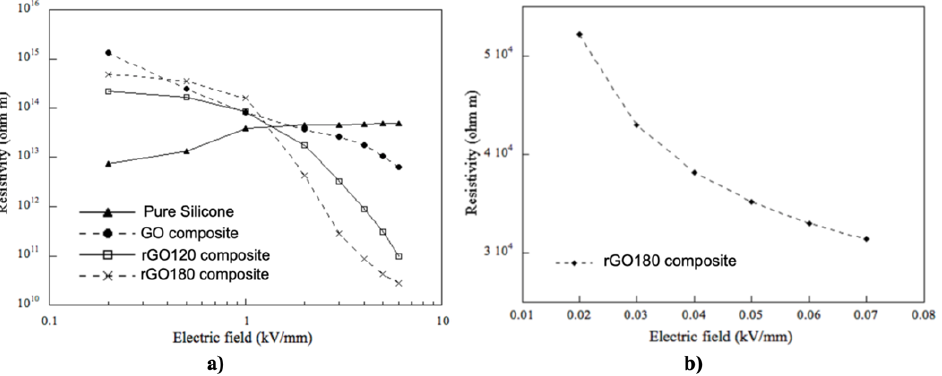
Figure 29. DC resistivity of ( a ) SiR (triangles) and composites based on GO (circles), rGO120 (squares), rGO180 (cross), and ( b ) rGO220 (diamonds) as a function of electric field at 23 °C. © ( b ) rGO220 (diamonds) as a function of electric field at 23 ◦ C. © 2021 IEEE. Reprinted, with permission, from 2021 IEEE. Reprinted, with permission, from [76].